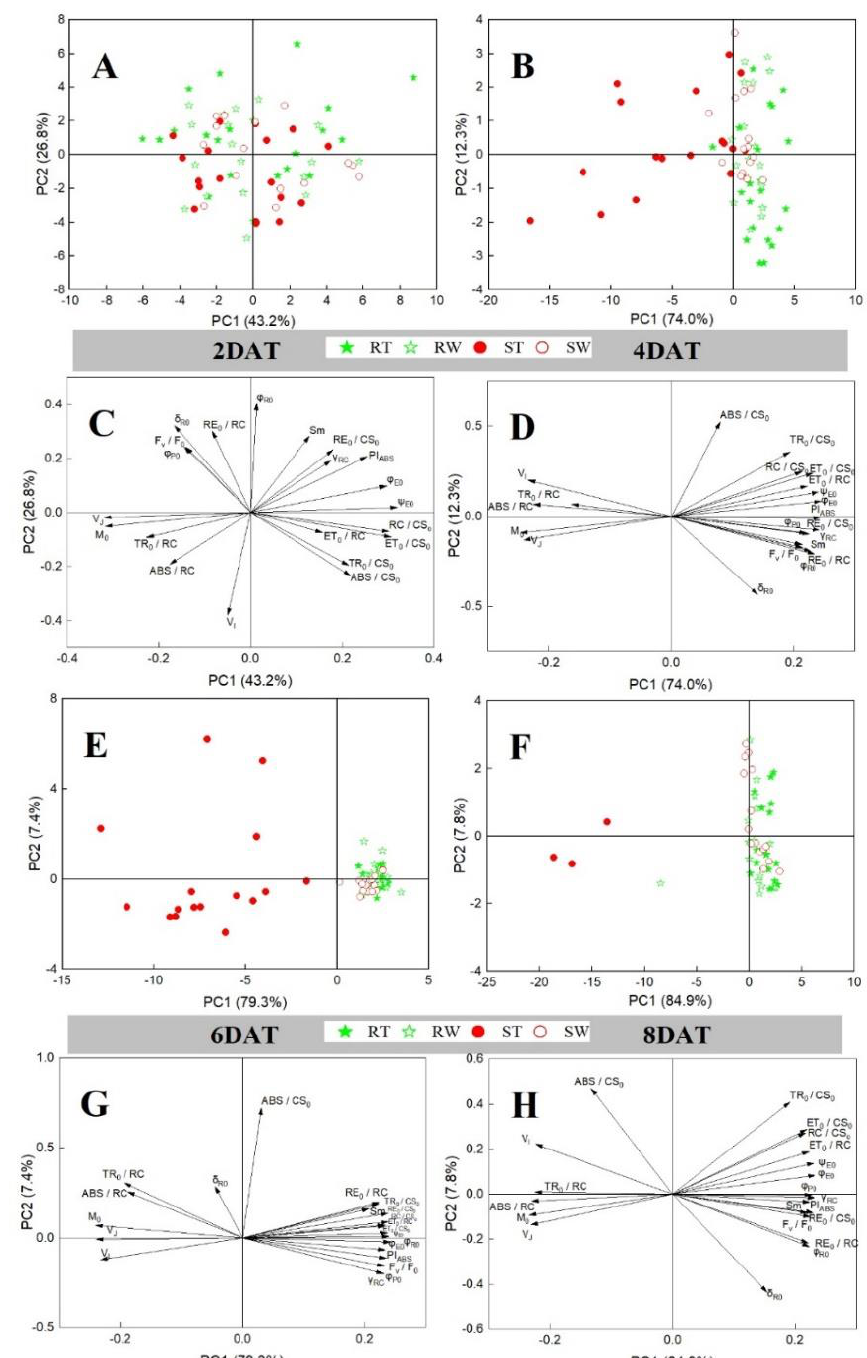
Figure 6. Principal component analysis of variation among 21 selected JIP − test parameters for RT (green solid pentacle), RW (green hollow pentacle), ST (red solid circle), and SW (red hollow circle) on 2 ( A , C ), 4 ( B , D ), 6 ( E , G ), and 8 ( F , H ) days after treatment (DAT). Correlation between variables ( C , D , G , H ) and the distribution of samples ( A , B , E , F ) along the first two PC axes are